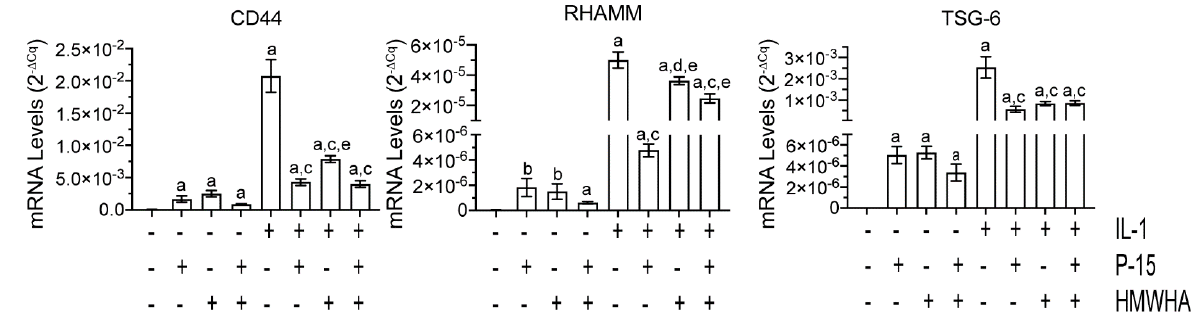
Figure 3. mRNA levels of HA receptors HA–binding proteins, CD44, RHAMM, and TSG–6 in vehicle–treated or IL–1 β – treated human BMSCs cultured in the absence or presence of P15–1 and HMWHA. Human BMSCs were serum–starved for 24 h followed by treatment with vehicle or IL–1 β in the absence or presence of P15–1, HMWHA, or P15–1 and HMWHA for 48 h. The mRNA levels of CD44, receptor for hyaluronan–mediated motility (RHAMM), and tumor necrosis factor– stimulated gene–6 (TSG–6) were determined by real–time PCR using SYBR Green and normalized to the level of 18S RNA. Data were obtained from triplicate PCRs using RNA from 3 different cultures. Values are the mean ± SD. a p < 0.01 vs. vehicle–treated cells; b p < 0.05 vs. vehicle–treated cells; c p < 0.01 vs. IL-1 β –treated cells; d p < 0.05 vs. IL–1 β –treated cells; e